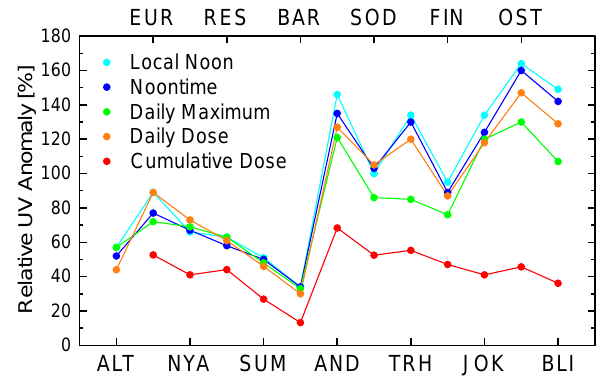
Fig. 4. Anomaly of UV measurements in 2011 relative to the cli- matological mean for the UVI measurement closest to local solar noon (data product (1), cyan); the UVI averaged over a period of ± 1h centered at local solar noon (data product (2), blue); the daily maximum UVI (data product (3), green); the daily erythemal dose (data product (4), orange); and the erythemal dose integrated over the low-ozone periods (data product (5), red). For data products (1)– (4), data are plotted for the day when the maximum UV anomaly occurred. For the Norwegian sites, data products (2) and (3) are based on data subsampled at 15-minute intervals. Site acronyms are defined in Table